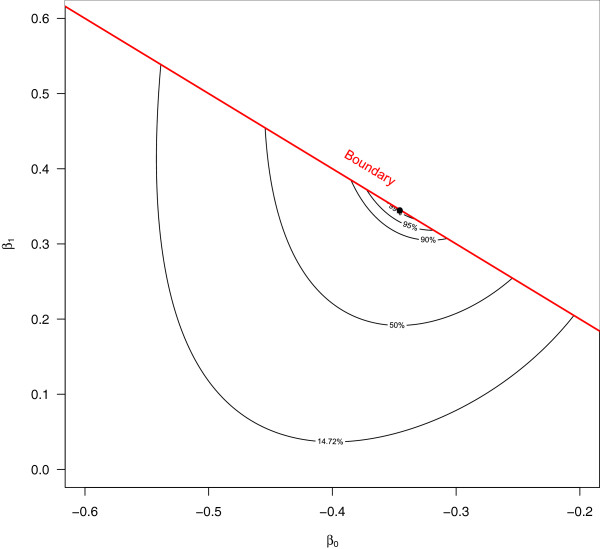
Log-relative likelihood contours for a log-binomial model with data in Table1.